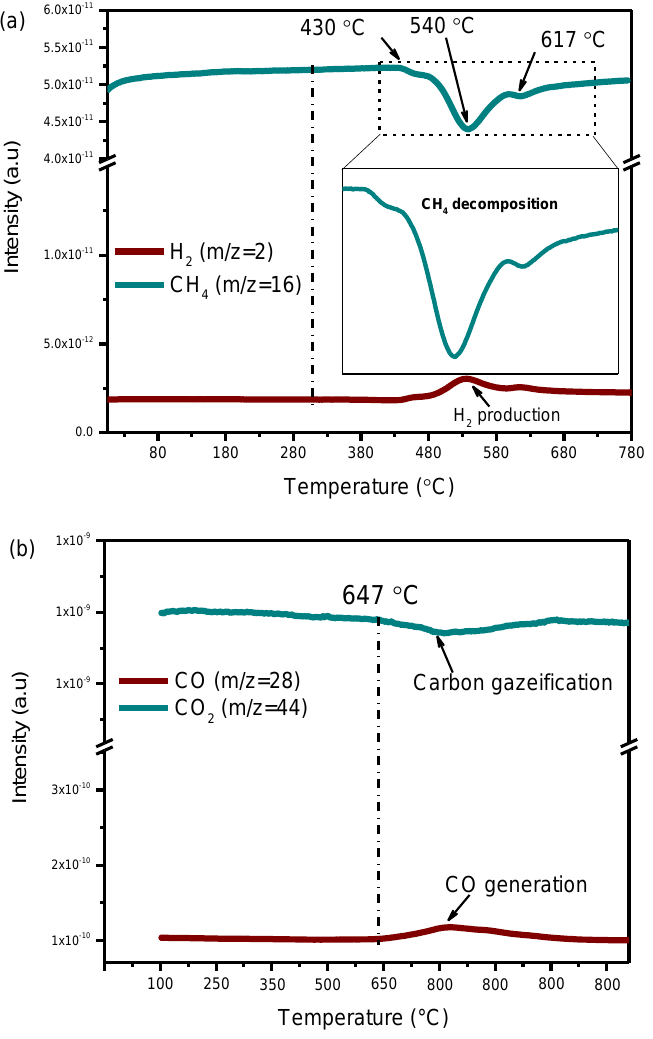
Figure 9. MS signal during ( a ) Individual CH 4 decomposition; ( b ) Subsequent gasification of deposited carbon with CO 2 . Conditions: 5Ni/HAP-NP catalyst, T = (25–900 °C). pure CH 4 and CO 2 were used with total flow of 10 mL mL −1 .